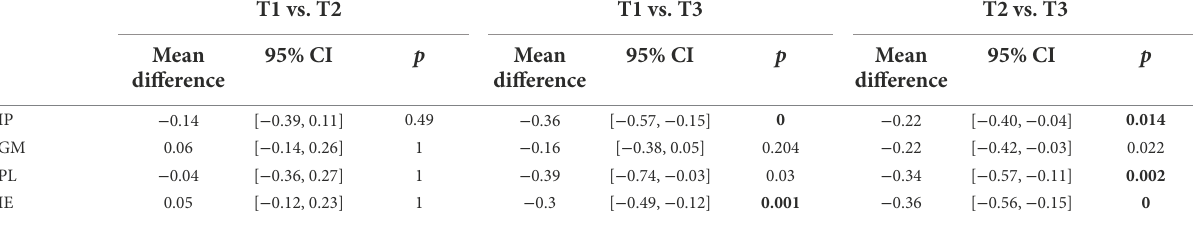
TABLE 8 Post-hoc tests of the mean difference on self-perceived self-regulated writing strategies reflected in questionnaires. T1 vs.